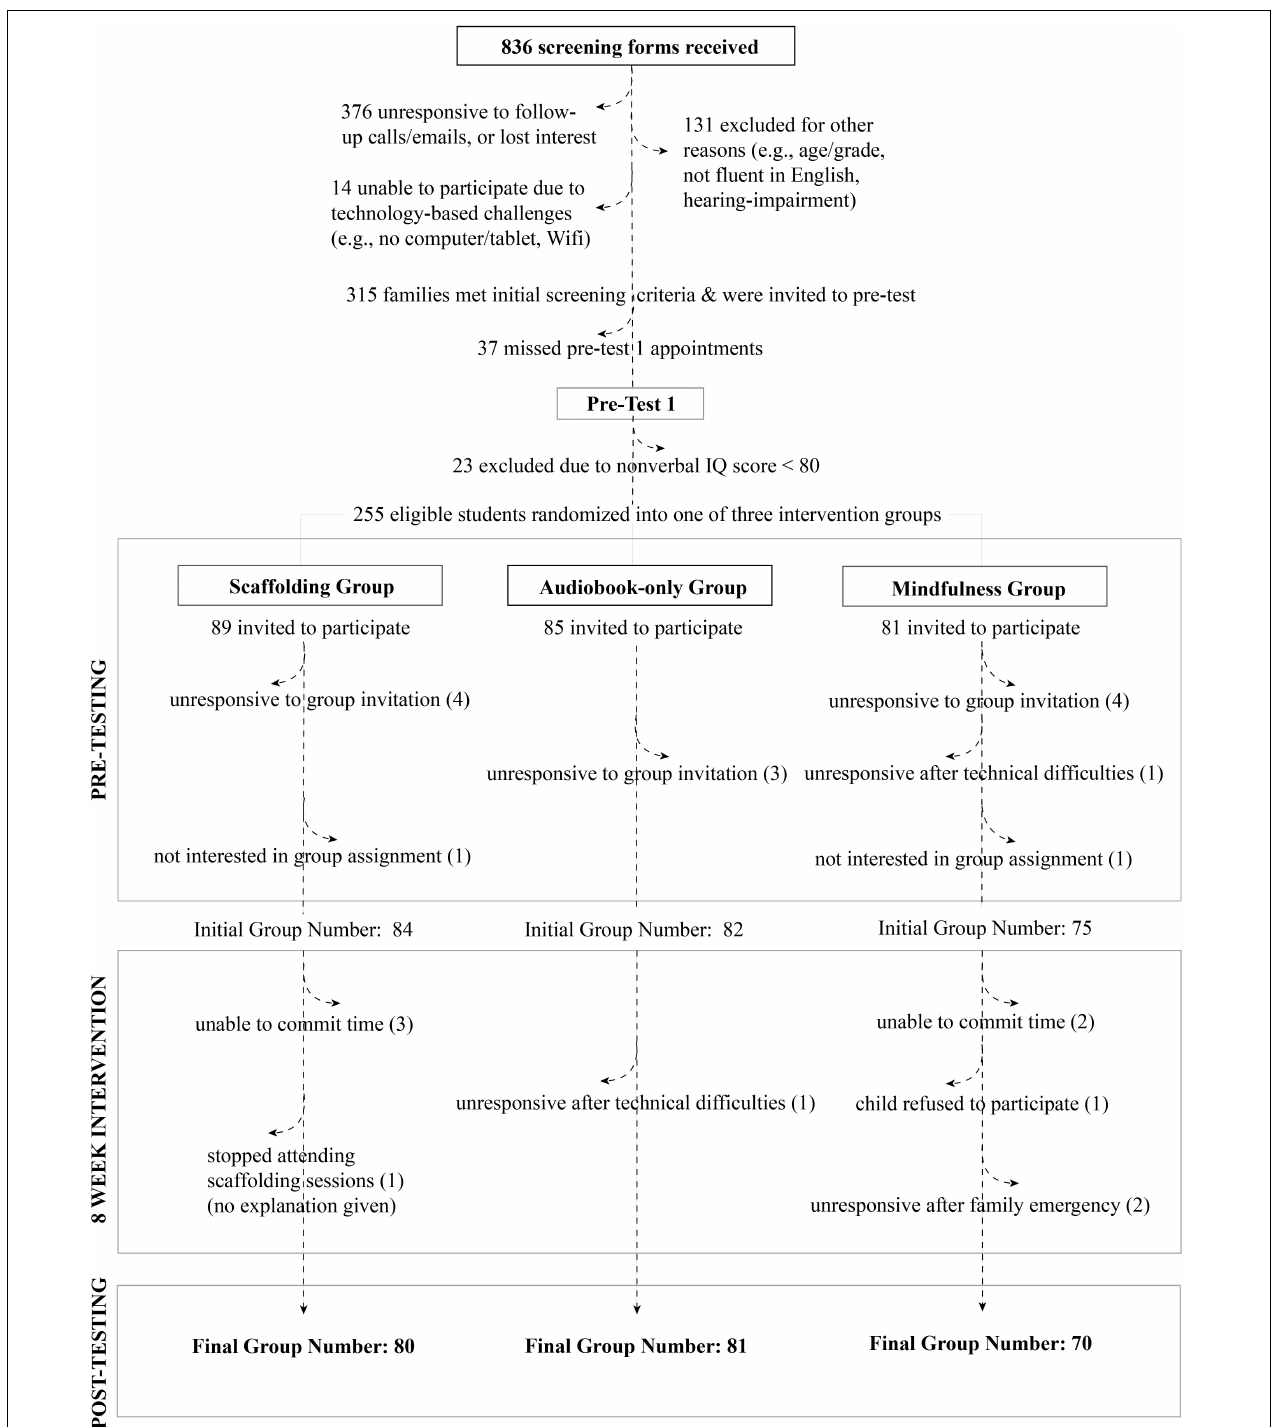
FIGURE 4 | Participant pipeline and